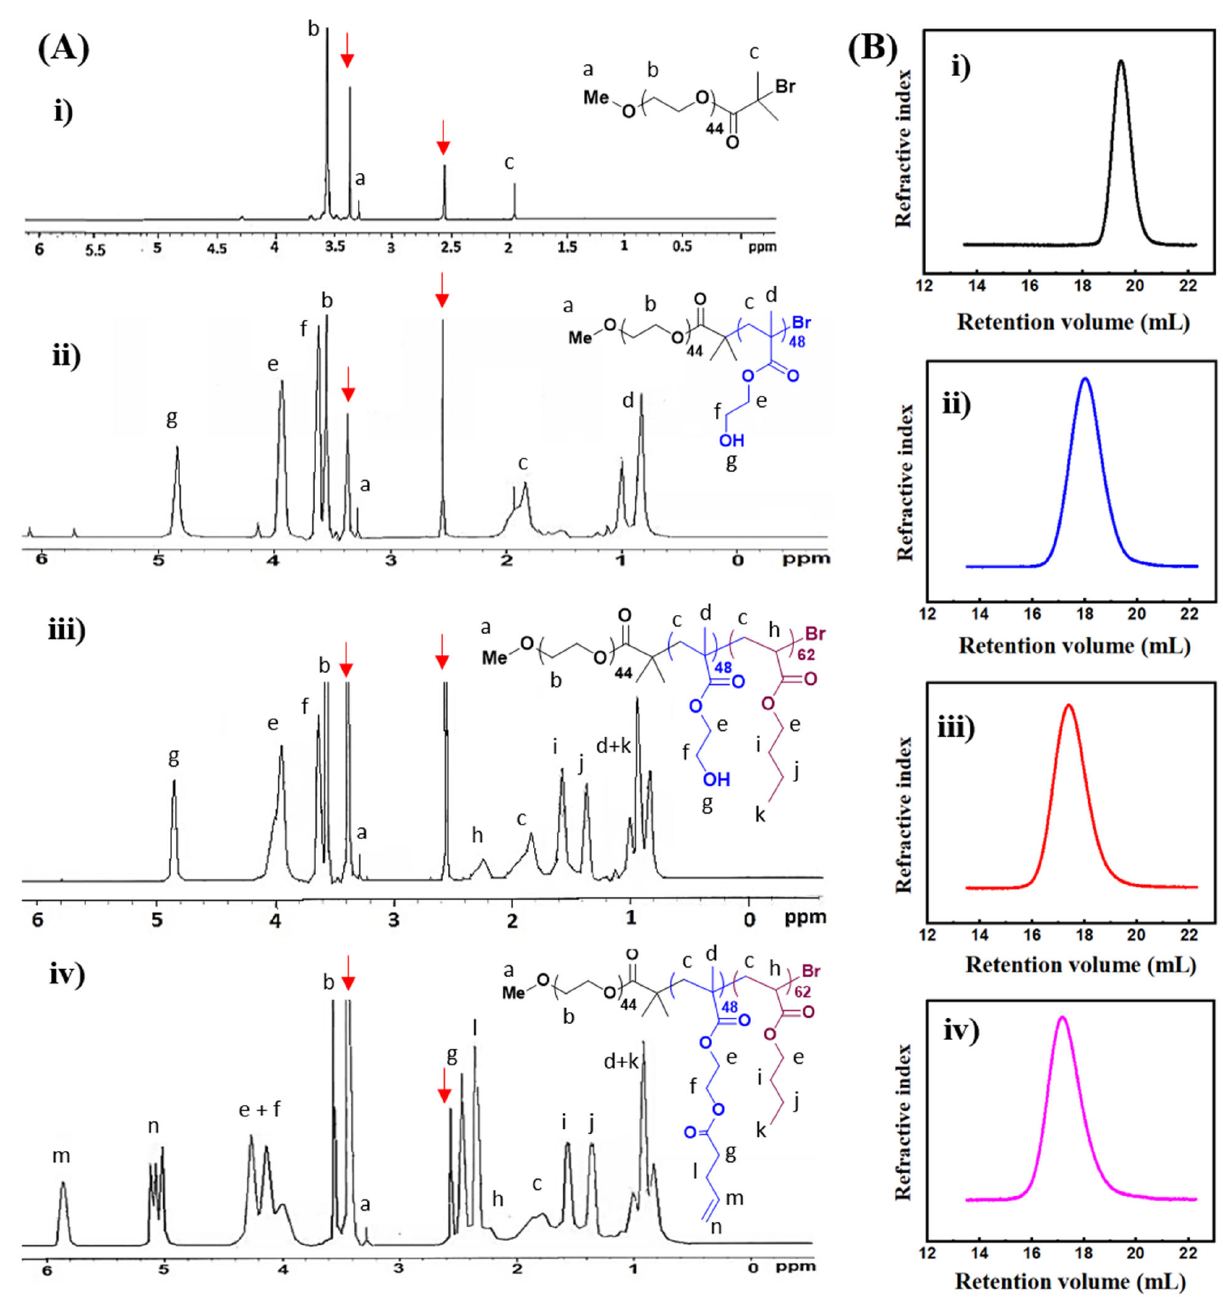
Figure 1. ( A ) 1 H NMR spectra and ( B ) GPC analysis of ( i ) PEG ‐ macroinitiator; ( ii ) PEG ‐ b ‐ PHEMA; ( iii ) PEG ‐ b ‐ PHEMA ‐ b ‐ PBA; and ( iv ) PEG ‐ b ‐ P(HEMA ‐ ene) ‐ b ‐ PBA in DMSO ‐ d 6 . Resonances from solvent are indicated with red arrows.